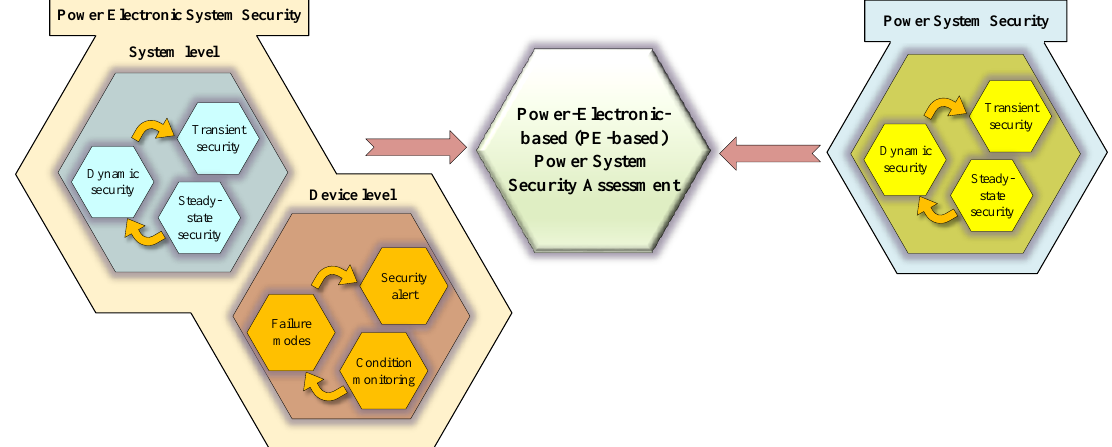
Figure 1. Overall schematic of the PE-based power system security assessment